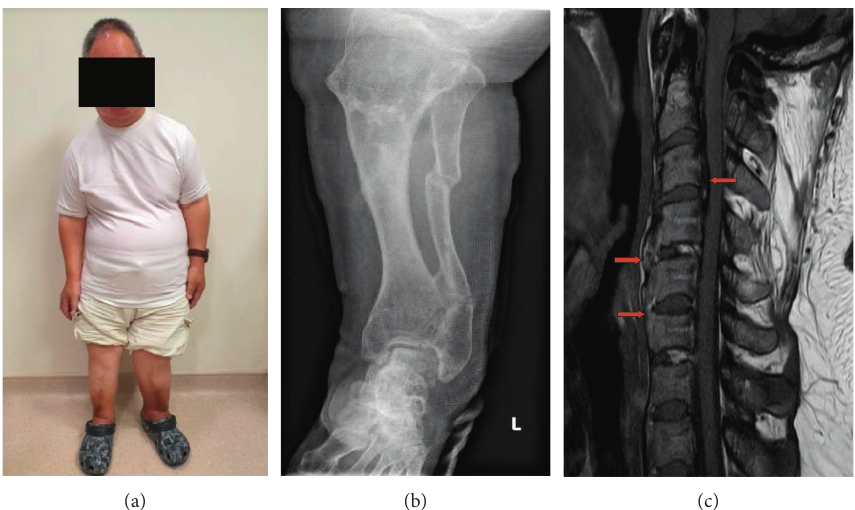
Figure 1: (a) Short stature, (b) deformities of the lower limb with recent fibular fracture, and (c) MRI cervical spine showing ossification of the anterior longitudinal ligament from C3 to C6 and posterior longitudinal ligaments from C2 to C4 (arrows).